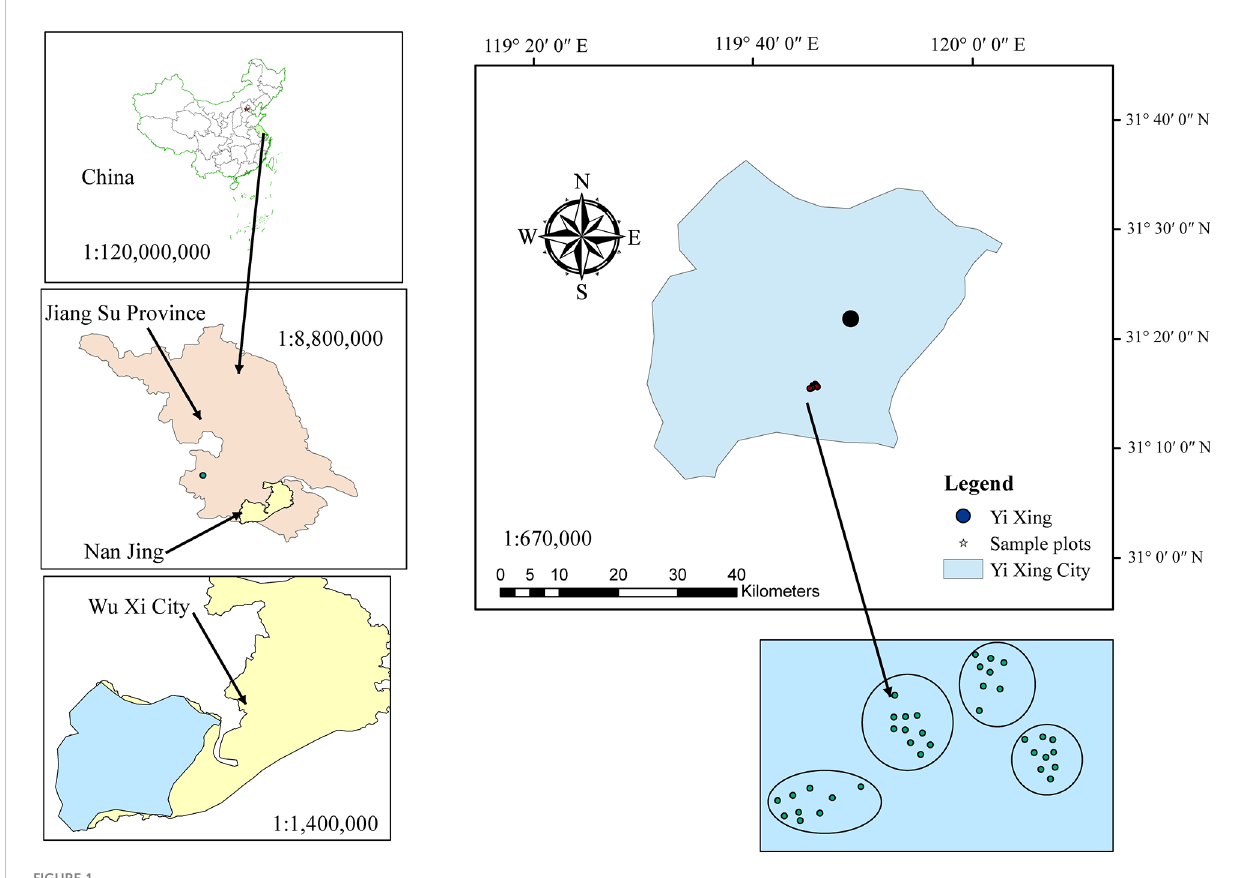
FIGURE 1 Location of the study